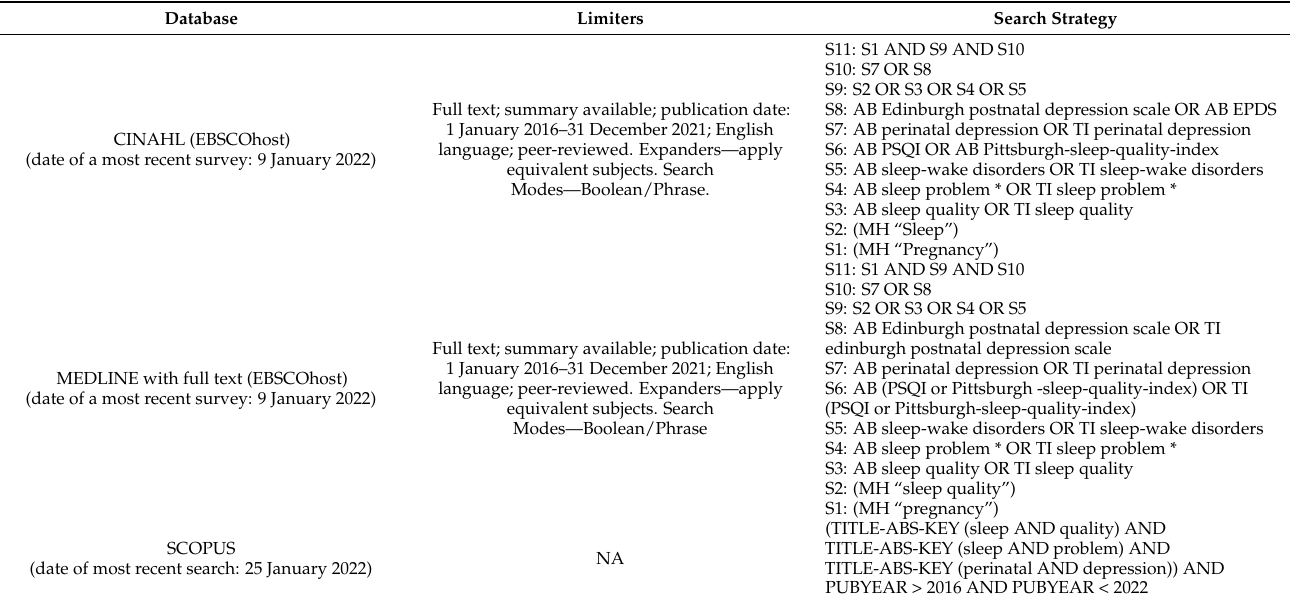
Table 1. Databases and research strategy.